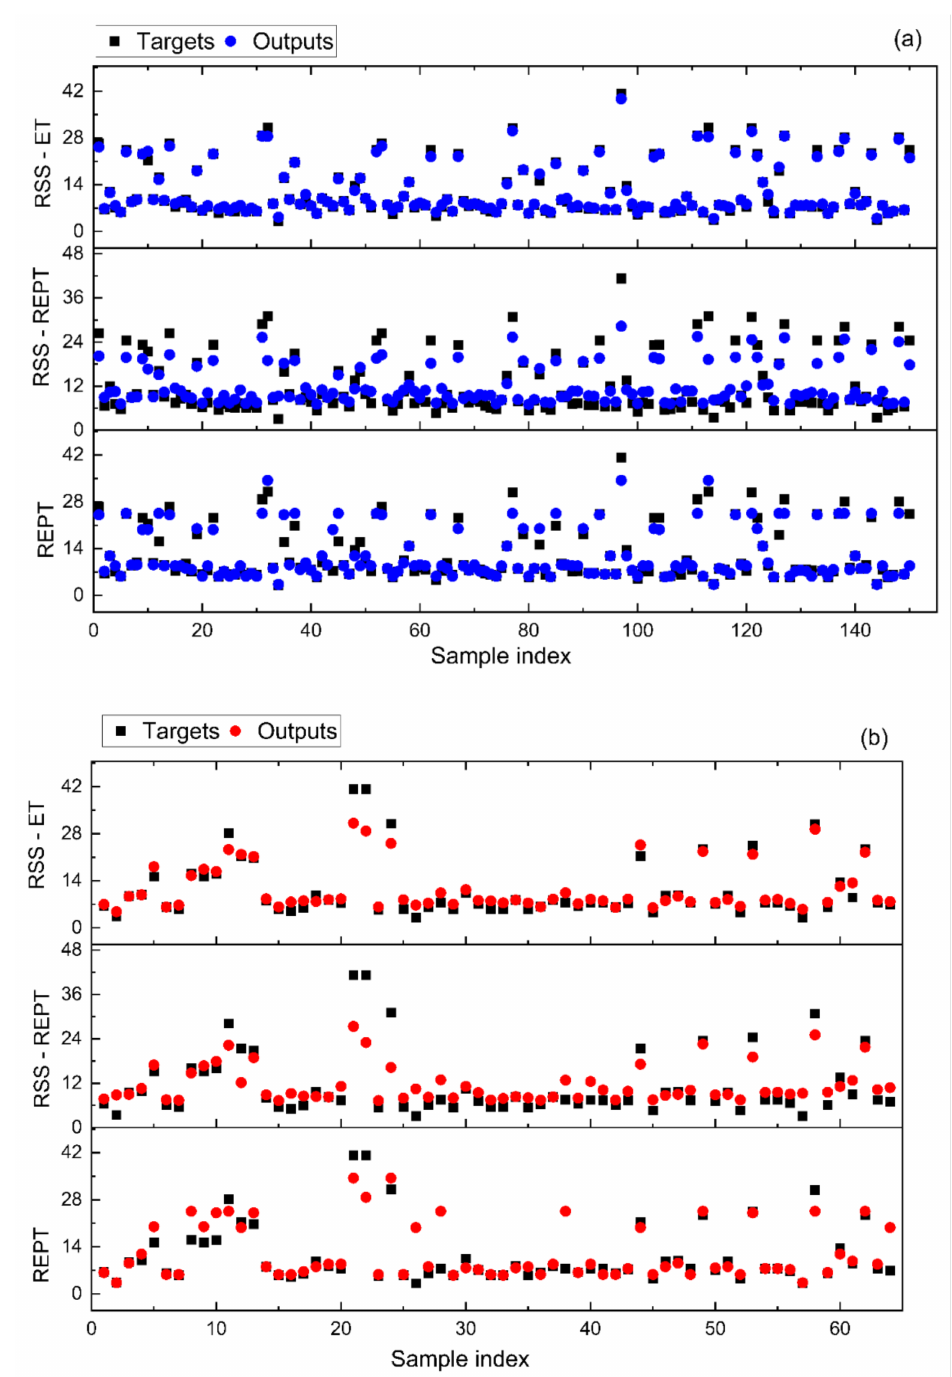
Figure 5. Comparison of the predicted and actual results: ( a ) Training and ( b ) test